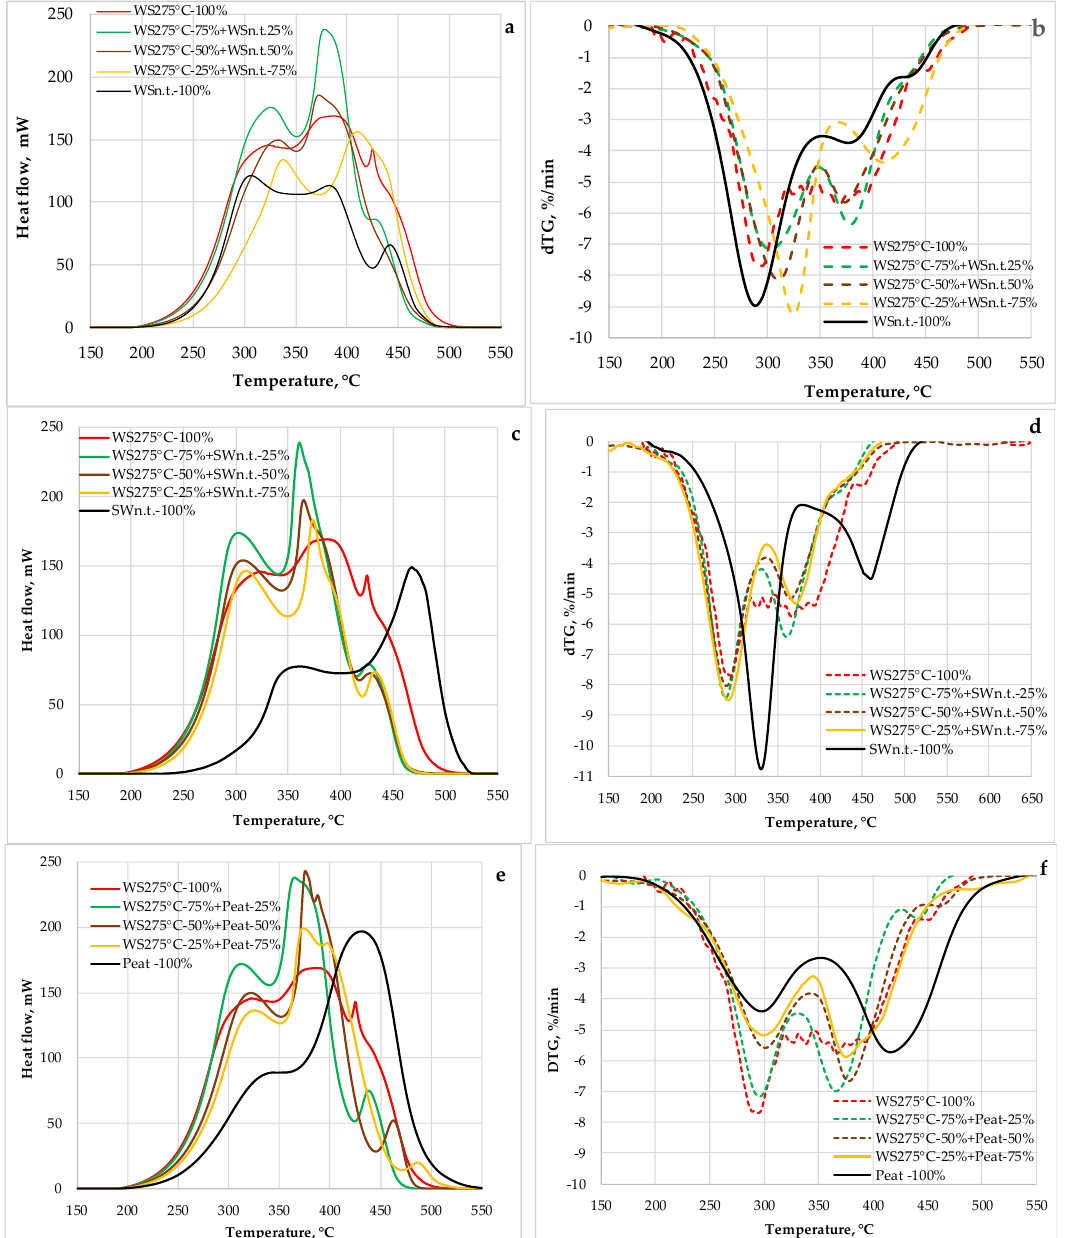
Figure 7. The DSC ( a , c , e ) and DTG ( b , d , f ) curves of binary blends containing MW pre-treated wheat straw and non-treated biomass of different